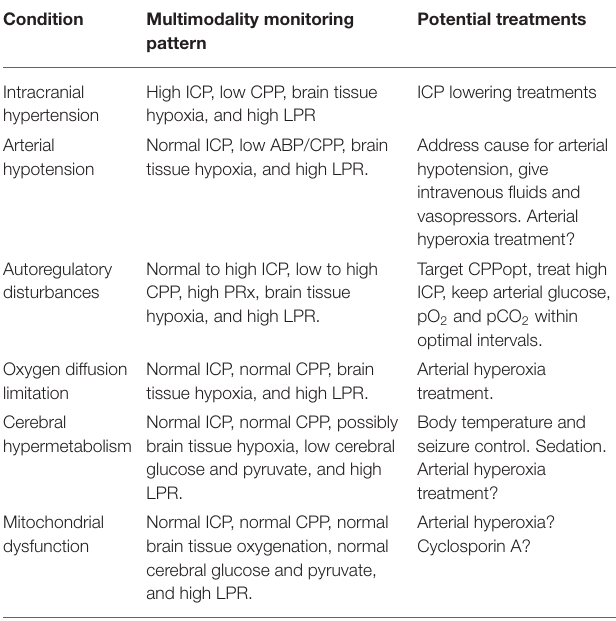
TABLE 3 | Secondary brain injury conditions, multimodality monitoring patterns and potential cause-specific treatments.